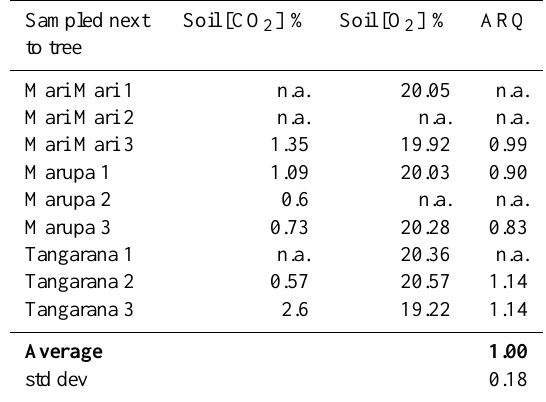
Table 2. Results of soil air sampling in the dry season. The analyti- cal error in ARQ estimate is 0.05 on